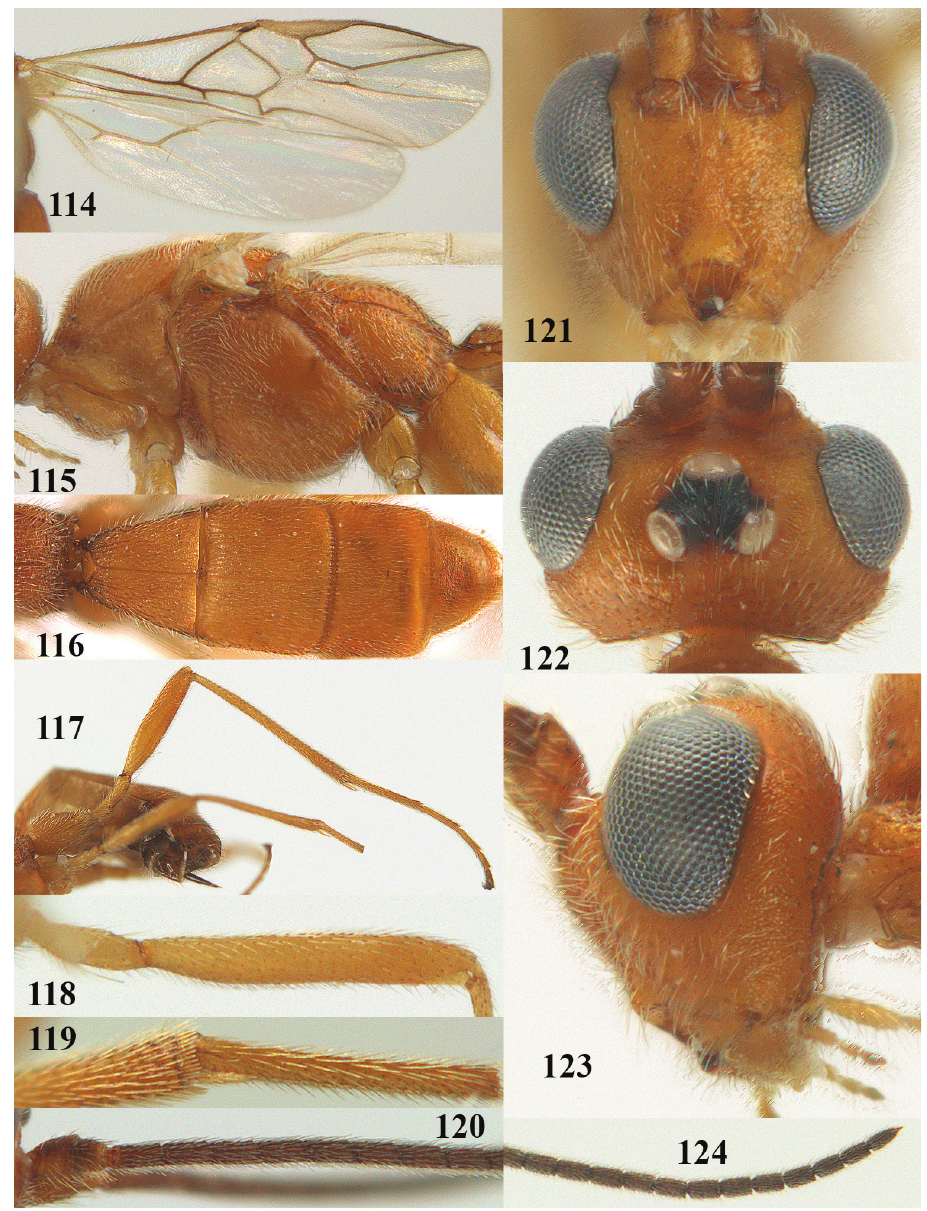
Figures 114–124. Aleiodes carminatus sp. n., ♀ , holotype. 114 wings 115 mesosoma lateral 116 pro- podeum and metasoma dorsal 117 hind leg lateral 118 fore femur lateral 119 inner side of hind tibial apex lateral 120 basal segments of antenna 121 head anterior 122 head dorsal 123 head lateral 124 apical segments of